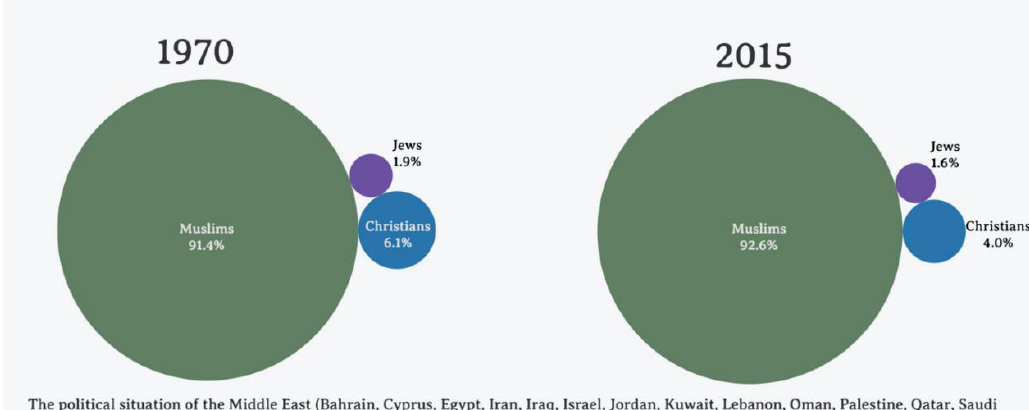
Figure 5. The changing diversity of the United States, 1970 and 2015.